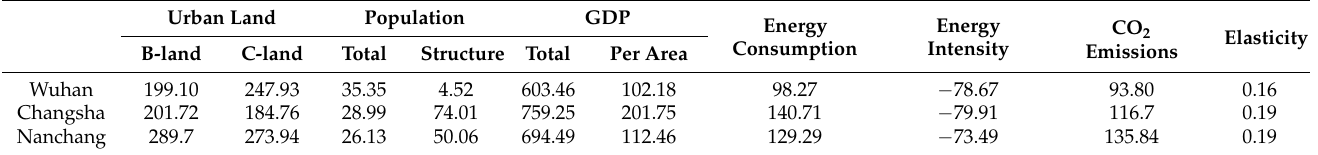
Table 2. Elementary change in three regions for 2000–2017